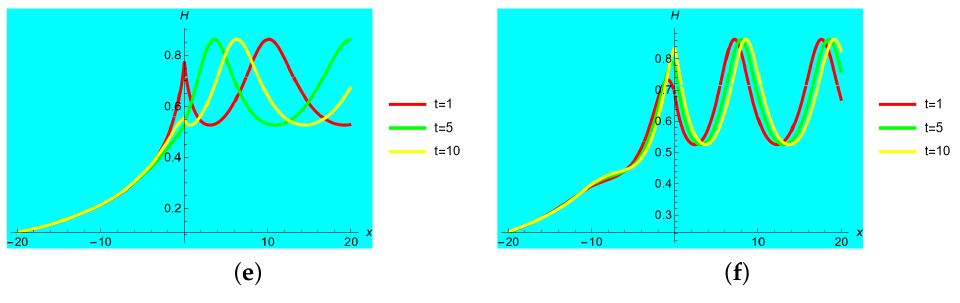
Figure 5. New exact solution by Nucci’s method (96) for the values of α = − 0.5, κ = 0.2, ω = 0.5, δ = 0.01, γ = − 2, ϕ 1 = 2.5. ( a ) 3-D wave profile at fractional order ζ = 0.7. ( b ) 3-D wave profile at fractional order ζ = 0.9. ( c ) Contour wave profile at fractional order ζ = 0.7. ( d ) Contour wave profile at fractional order ζ = 0.9. ( e ) 2-D wave profile at fractional order ζ = 0.7. ( f ) 2-D wave profile at fractional order ζ =